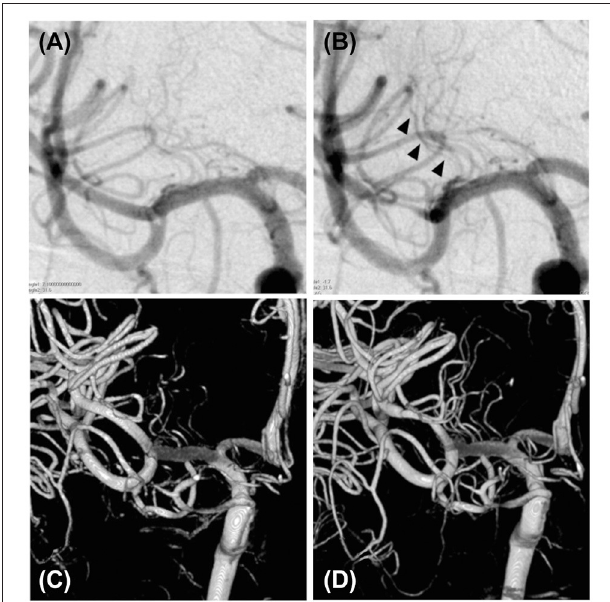
FIGURE 3 | Visualization of the lateral lenticulostriate artery before and after the mechanical thrombectomy. (A) Cerebral angiography of the right internal carotid artery showing a suspected poor lateral lenticulostriate artery appearance before mechanical thrombectomy. (B) Cerebral angiography of the right internal carotid artery showing recanalization of the thrombus after mechanical thrombectomy (black arrowhead). (C) Three-dimensional reconstruction of the lateral lenticulostriate artery from the cerebral angiography of the right internal carotid artery, showing a poor appearance of the lateral lenticulostriate artery before the mechanical thrombectomy. (D) Three-dimensional reconstruction of the lateral lenticulostriate artery from the cerebral angiography of the right internal carotid artery showing improved lateral lenticulostriate artery appearance after mechanical